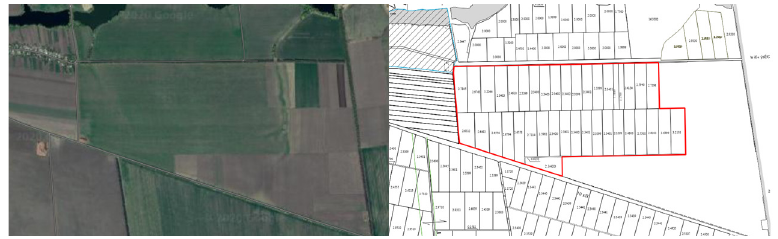
Figure 6. Land plots placement and usage within the second land mass (source: https://map.land.gov.ua/)